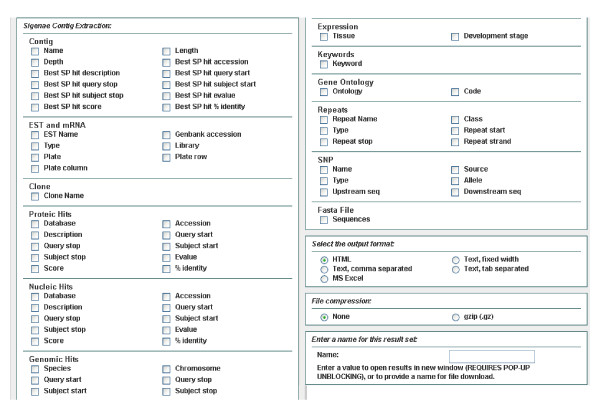
Output page available with BioMart in GigasDatabase. Once the filters have been selected, it is possible to select elements for output. For example, best SwissProt (SP) description, best SP hit score, or best SP hit E-value can be exported in several output formats (HTML, Text, MS Excel).